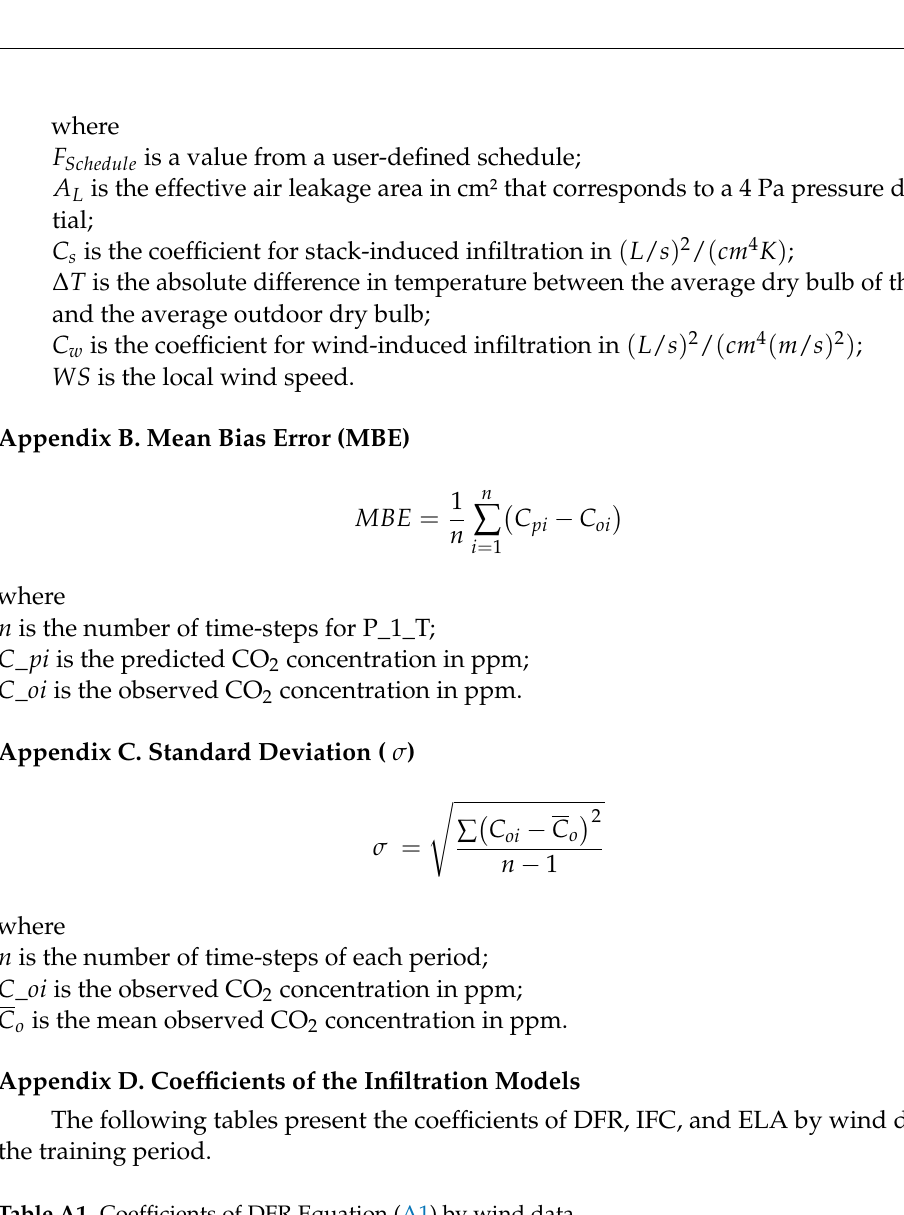
Table A1. Coefficients of DFR Equation (A1) by wind data.